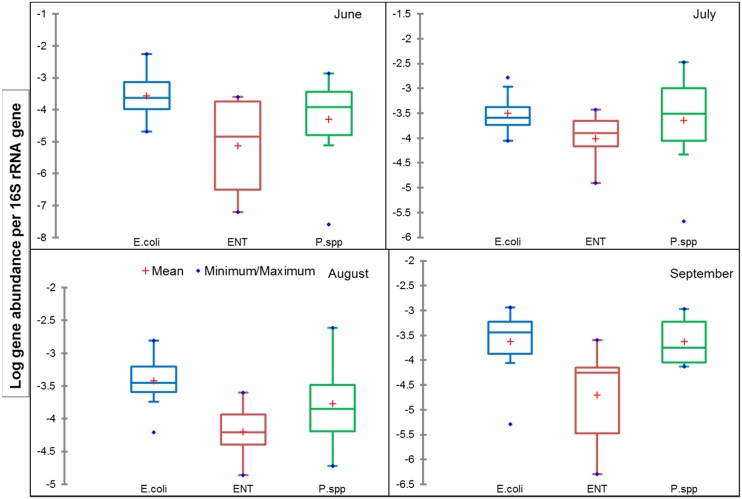
Gene copy number of selected bacterial species (E. coli, ENT, and Pseudomonas spp.) normalized to 16S rRNA gene copy numbers in sediment samples collected for 4 months (June to September) at selected HOP.The box plot represents the first and third quartile, the blue dots on maximum/minimum values and the red cross indicate mean.